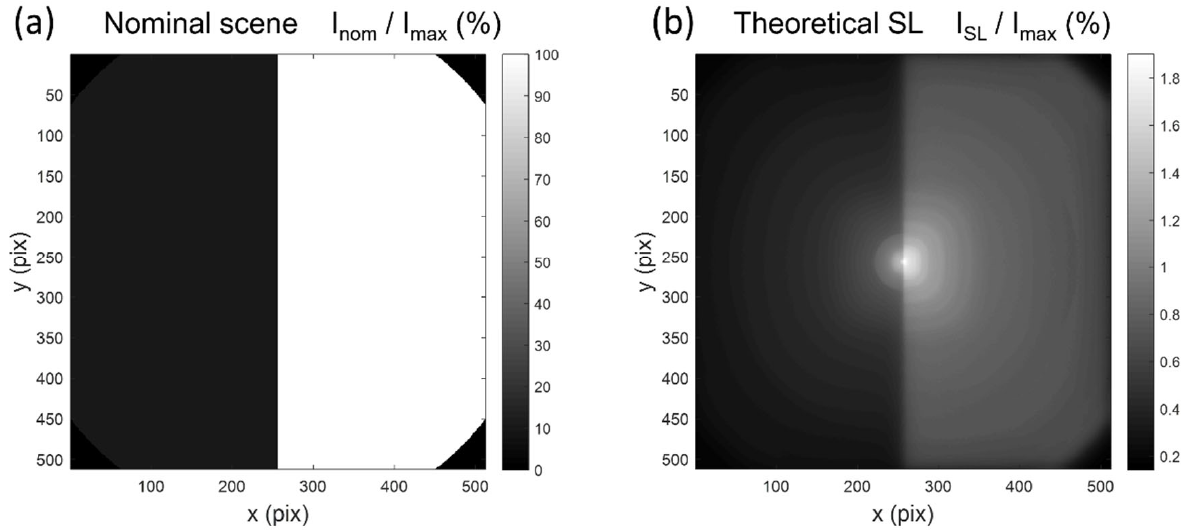
Figure 1. Nominal signal for the B and W extended scene ( a ) and corresponding SL computed by ray tracing at 410 nm ( b ).